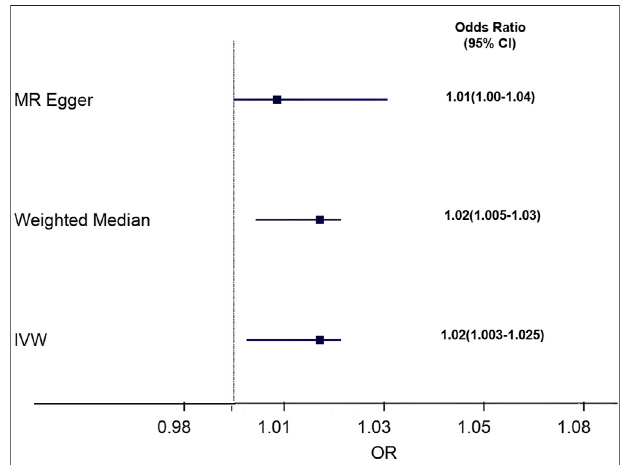
FIGURE 4 | Forest plot to visualize causal effect of Cystatin C on osteoporosis risk. IVW indicates inverse-variance weighted; and MR, Mendelian